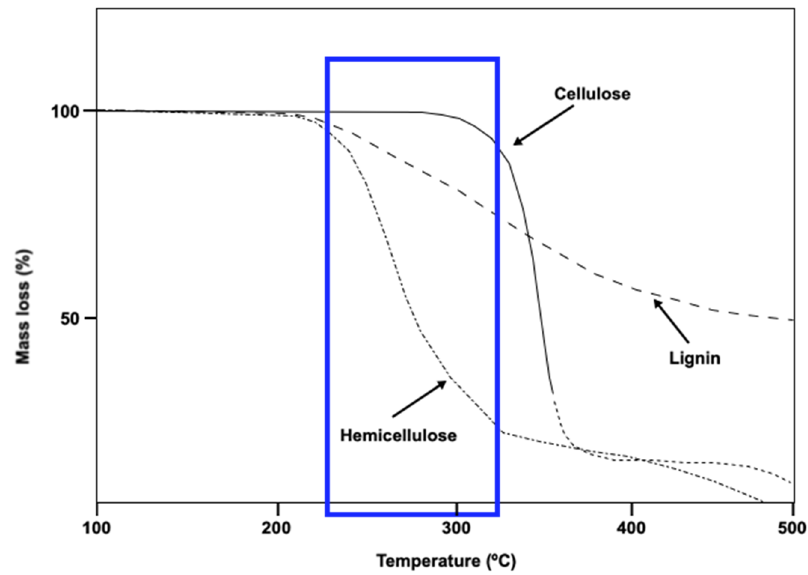
Figure 21. Exemplary model of the behavior of the main components of biomass of vegetal origin with the increase of the temperature. Blue square figure represents the temperature range where torrefaction occurs, when considered the definition of torrefaction as being a thermochemical conversion process occurring in a temperature range between 220 and 320 °C, under atmospheric pressure conditions and in the absence of oxygen, where the molecular disintegration of the hemicellulose occurs, maintaining lignin and cellulose in its original state and structures. This definition was developed during the development to refine the torrefaction process in the pilot unit under analysis.